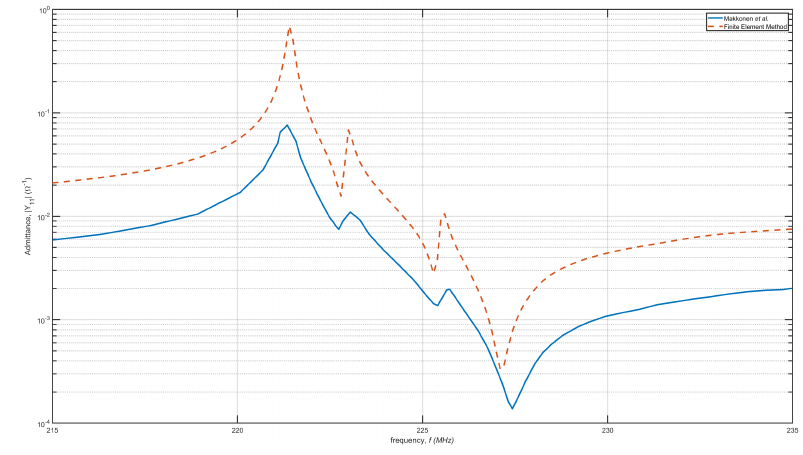
Figure 8. Admittance as a function of frequency estimated by FEM and Makkonen et al.